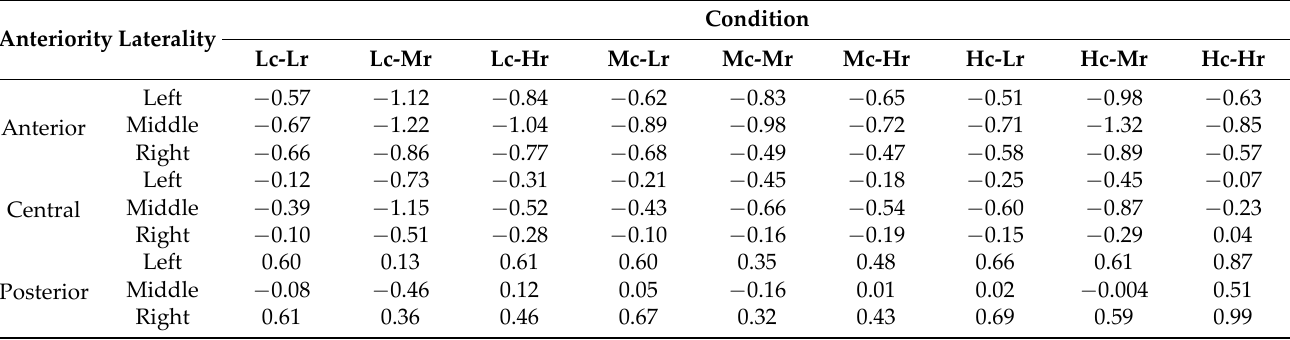
Table 2. Descriptive statistics of the P300 electrophysiological results.